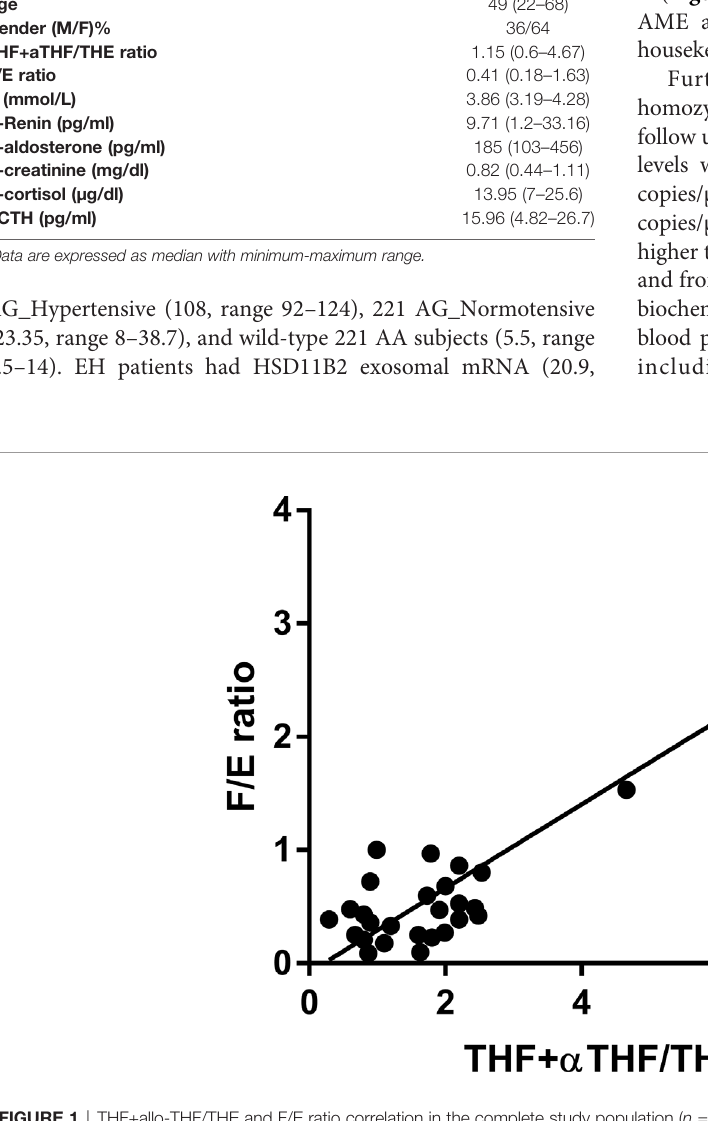
TABLE 2 | Biochemical and clinical features of EH patients*. Age